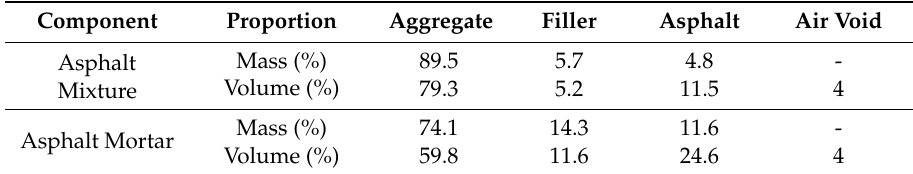
Figure 1. Samples of asphalt mixture and mortar: ( a ) Beam samples; and, ( b ) Cylindrical samples. Table 6. Each component content of asphalt mixes.